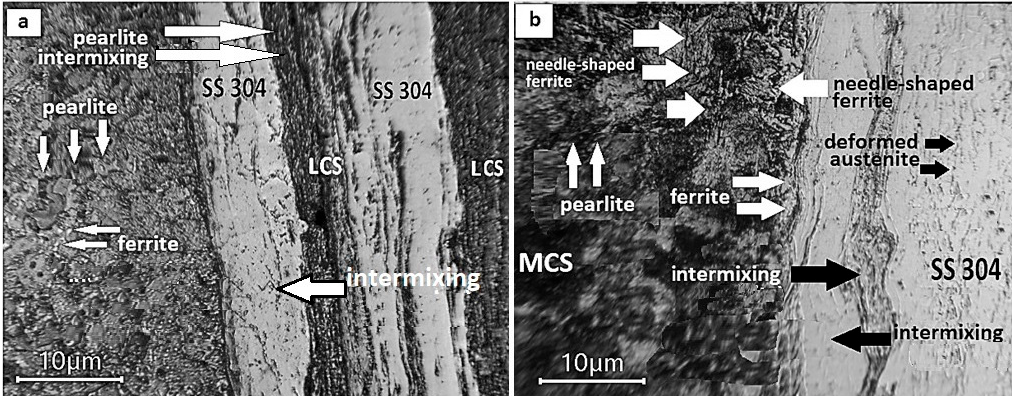
Figure 6. Microstructure of the interface at the joint of low-carbon steel–304 SS ( a ) and medium-carbon steel–304 SS ( b ).